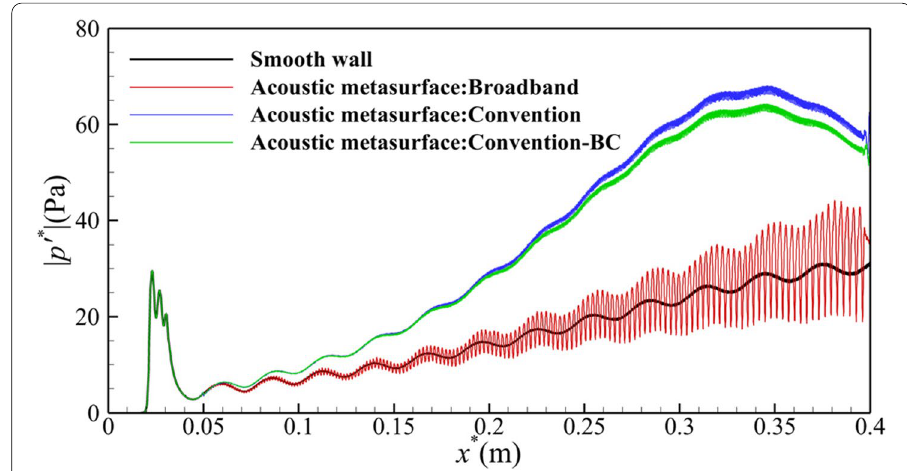
Fig. 11 Comparisons of wall fluctuating pressure amplitude distributions. (BC: calculated with the impendence boundary